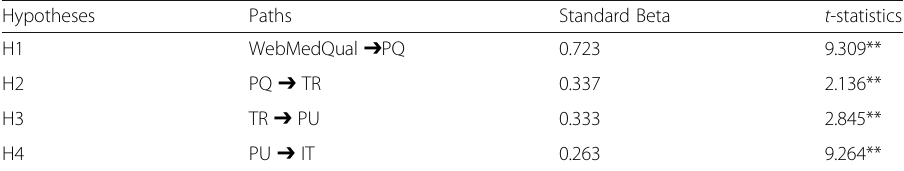
Table 5 Structural estimates (hypotheses